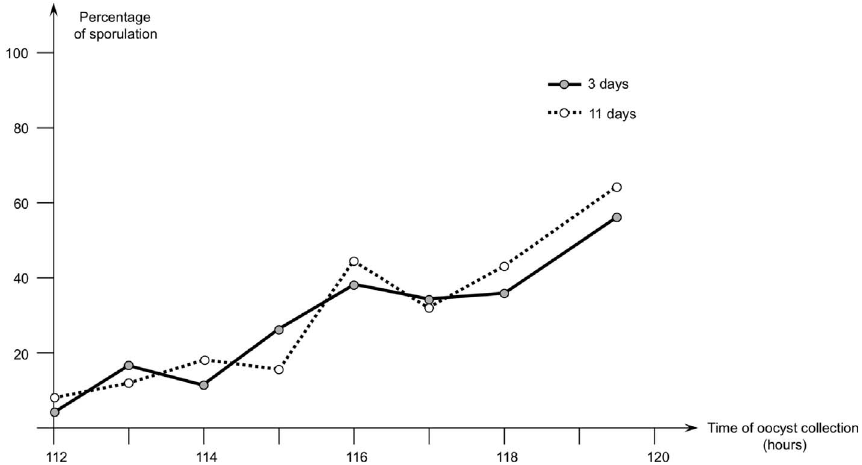
Figure 4. Second study with Eimeria acervulina - evolution of the percentage of sporulation of oocysts of E. acervulina (isolate no. 7) collected in the duodenum from 112 to 119.5 h after infection. Percentage of sporulation was evaluated after 3 and 11 days of incubation at 28 (cid:3)